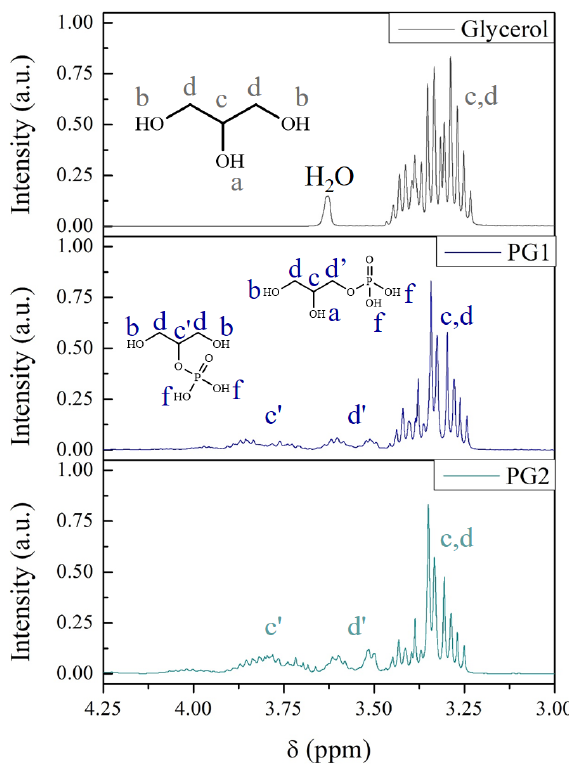
Figure 5. 1 H-NMR spectra of phosphorylated glycerol products PG1, PG2 and pure glycerol as reference.